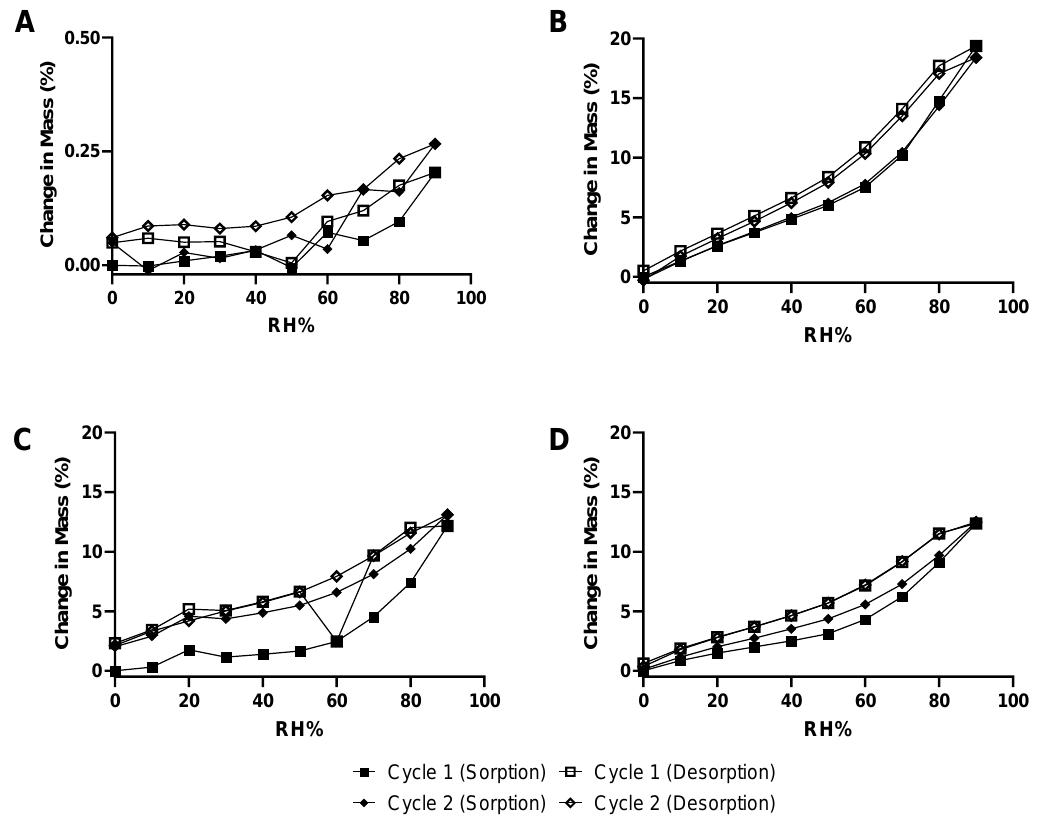
Figure 4. Moisture sorption isotherms of ( A ) Raw nitrofurantoin ( B ) Raw HPMC ( C ) 2FN and ( D ) 3FN. The percentage change in mass at 25 °C is shown when RH % was increased from 0 – 90% (sorption) and 90 – 0% (desorption) twice, represented as cycle 1 and cycle 2.